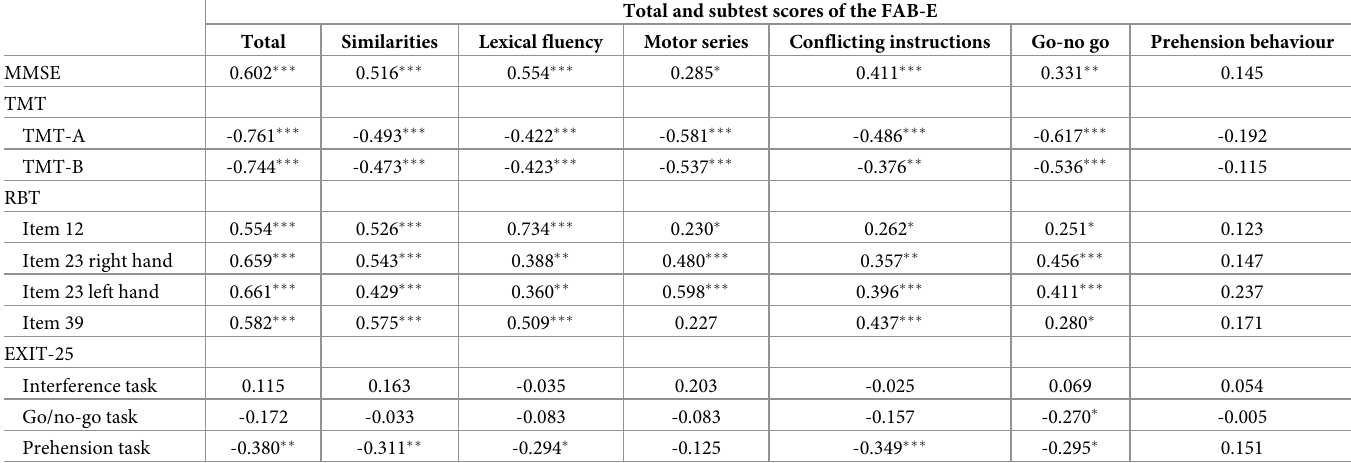
Table 3. Concurrent validity using Spearman correlations between the performance on the FAB-E and the other neuropsychological tests among Parkinson’ disease patients (n = 67).